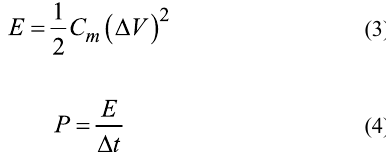
The superior supercapacitive behavior of the Cu/CuO/PCNF/ TiO 2 composite is attributed to the following aspects: (i)